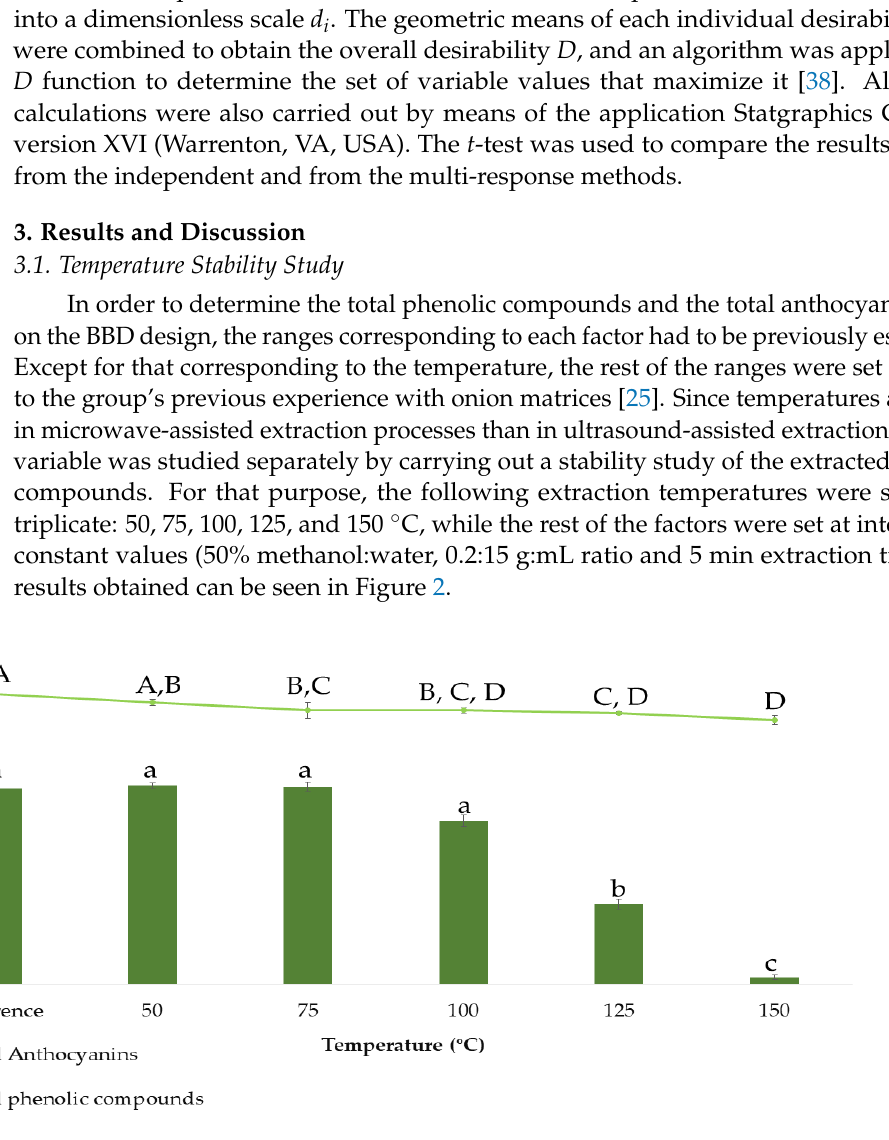
Figure 2. Stability study on total anthocyanins and total phenolic compounds content (means ± SD). Different letters mean statistically significant differences according to Tukey’s test at the 95% level of significance.